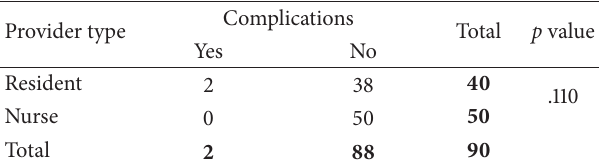
Table 2: Relationship between provider type and complications in the use of ultrasound guided IV